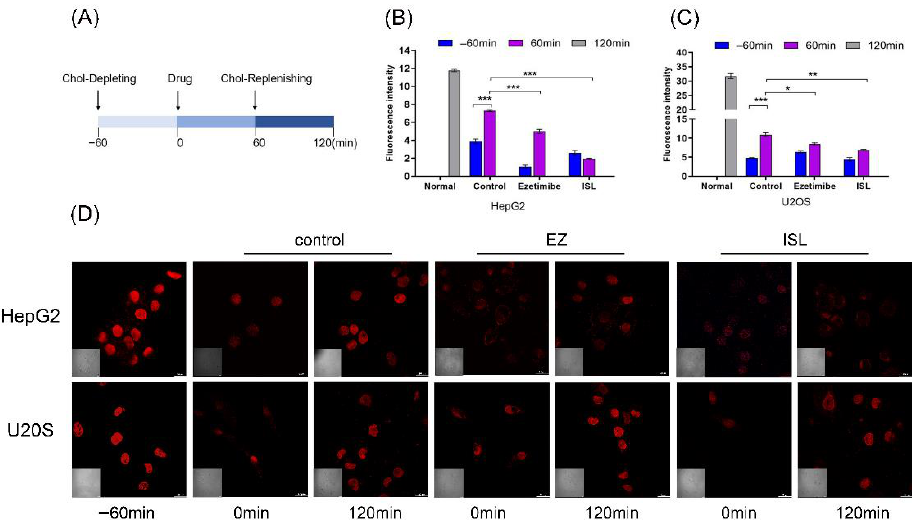
Figure 5. ISL inhibited cellular absorption of cholesterol by filipin bacteriocin staining. ( A ) The procedure used to treat the cells. ( B , C ) Quantification of total cholesterol of cells in ( D ). Error bars represent standard deviations. * p < 0.05, ** p < 0.001, *** p < 0.0001. ( D ) Cells were treated as shown in ( A ). Images were captured with Nikon confocal microscope after fixing cells and staining with filipin at different time points. Scale bar = 20 µ m.